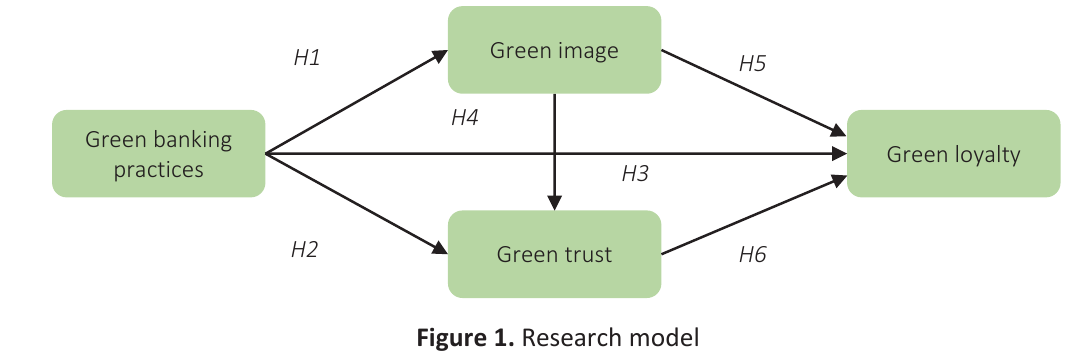
Figure 1. Research